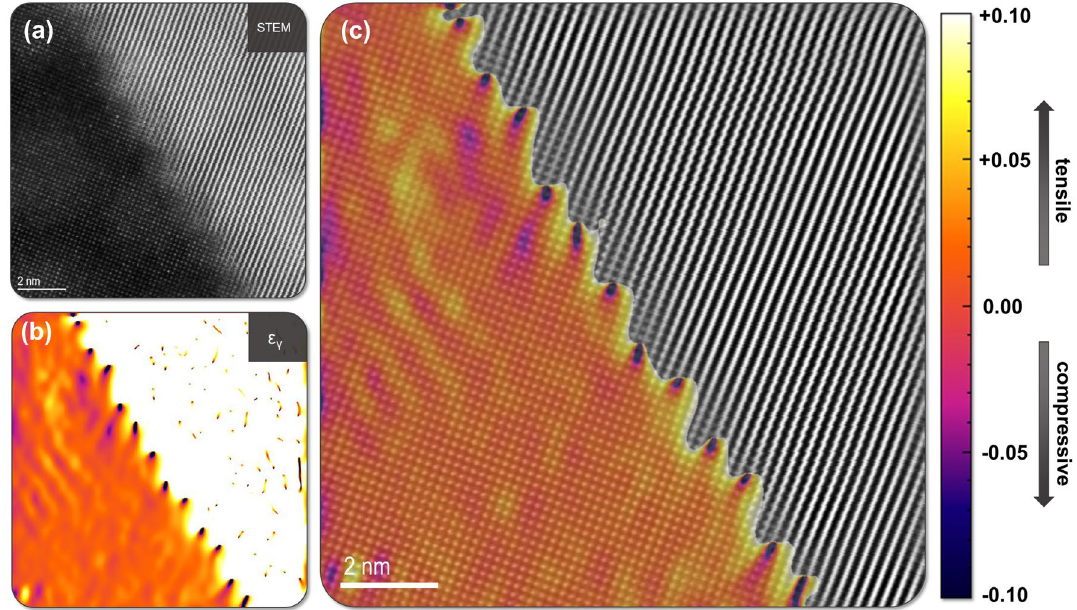
Figure 7. ( a ) Atomic column STEM micrograph of facet C in same orientation as shown in Fig. 4, ( b ) strain map of the lattice expansion along the γ{020} planes in ( a ), ( c ) overlay of γ-phase strain map from ( b ) and Fourier filtered micrograph from ( a ) at the interphase boundary highlighting the periodic strain field corresponding to misfit dislocations and coherency strain across the boundary plane. Note that the generated Strain++ 35 map has been optimized to only display variations in the γ-lattice therefore the overlay does not include contributions from the